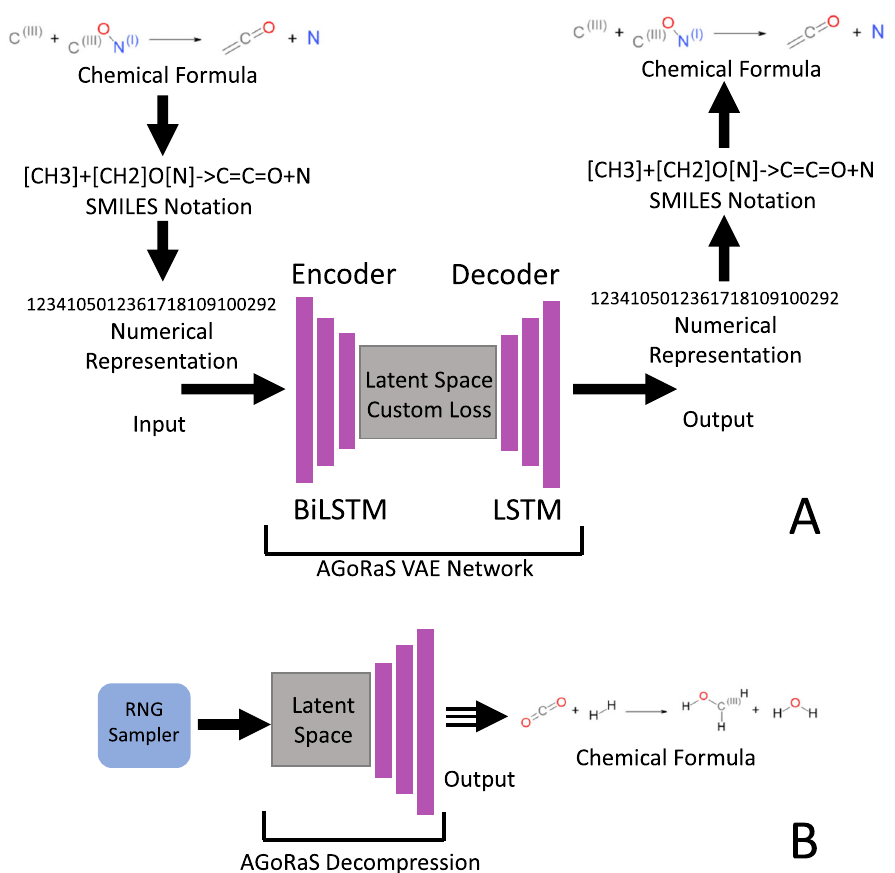
Fig. 1 Work fl ow of the AGoRaS-based VAE network. As illustrated in ( A ), the chemical database information is compressed and decompressed to form a high-dimensional latent space. B illustrates the work fl ow of how the trained latent space is sampled to generate new chemical equations.